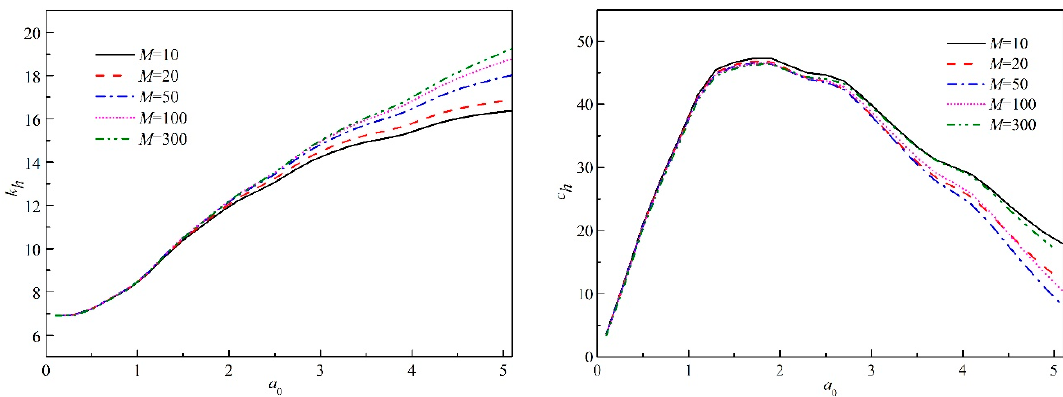
Figure 8 . Horizontal dynamic impedance of embedded foundation under different poroelastic material properties.